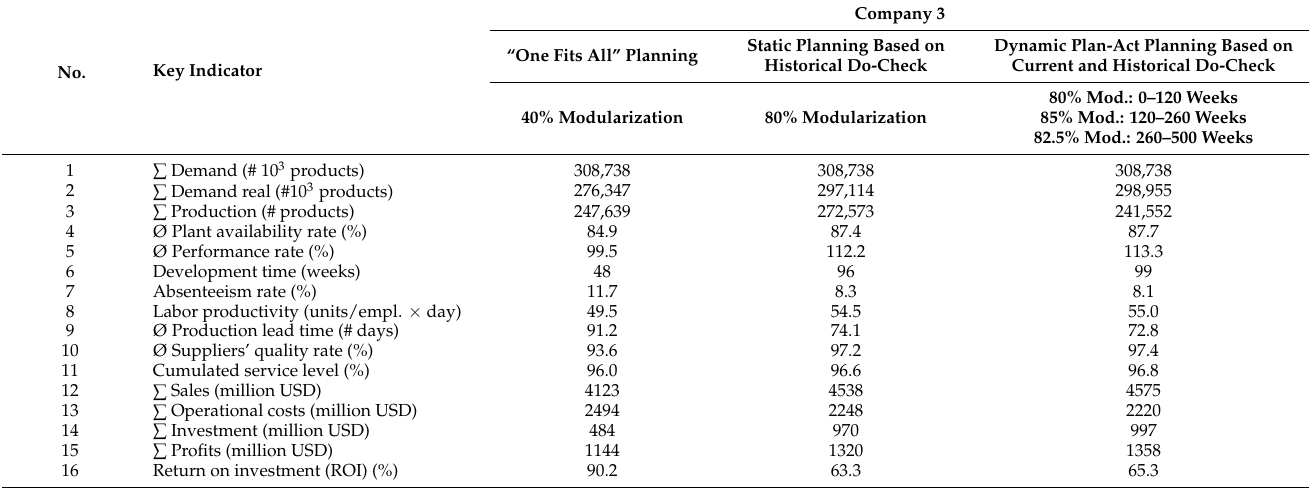
Table 3. Simulation results for the Innovation Case Study: Product Modularization in Company